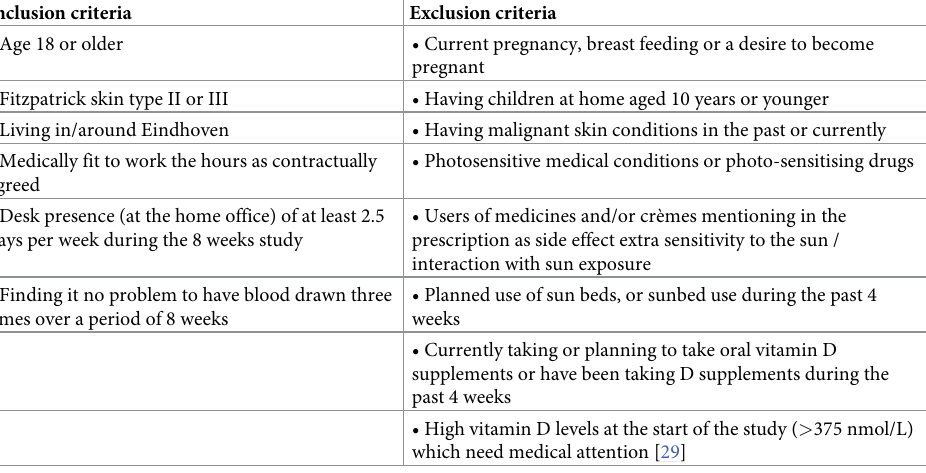
Table 1. In- and exclusion criteria for